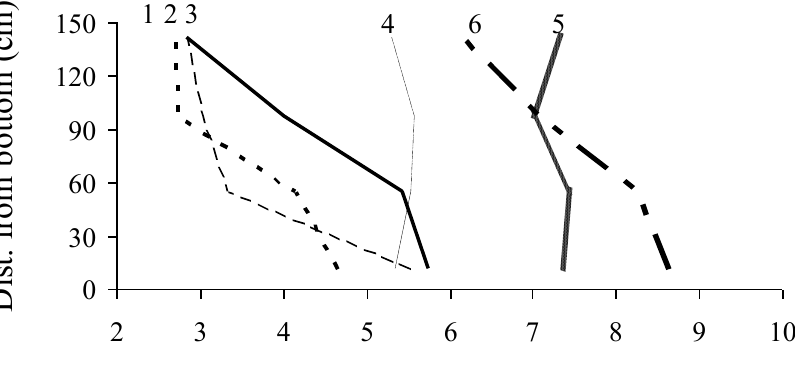
Figure 11. Variation in bond strength of prestressing strands along wall